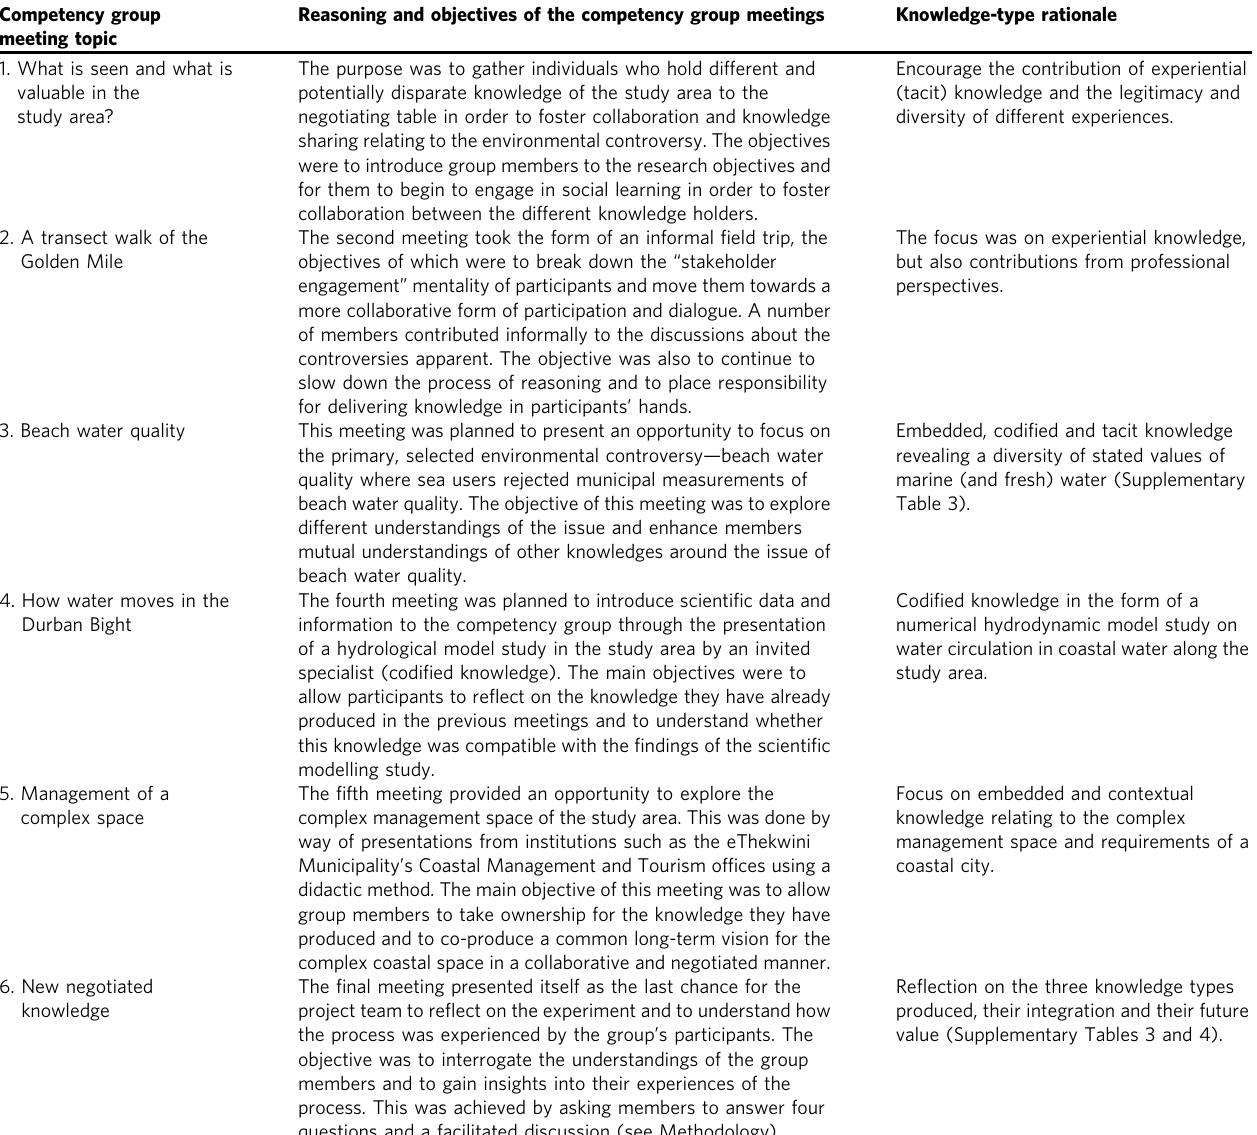
Table 1 Topics on social-environmental knowledge controversies of the Golden Mile, Durban, South Africa as discussed by the Competency